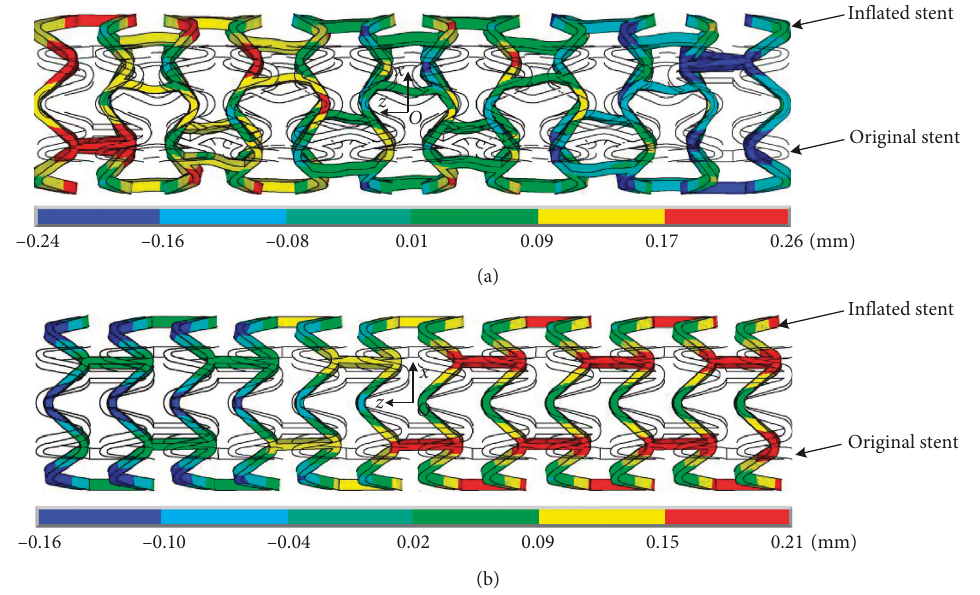
Figure 15: Deformations of the (a) OCS and (b) BVS at original and inflated states.